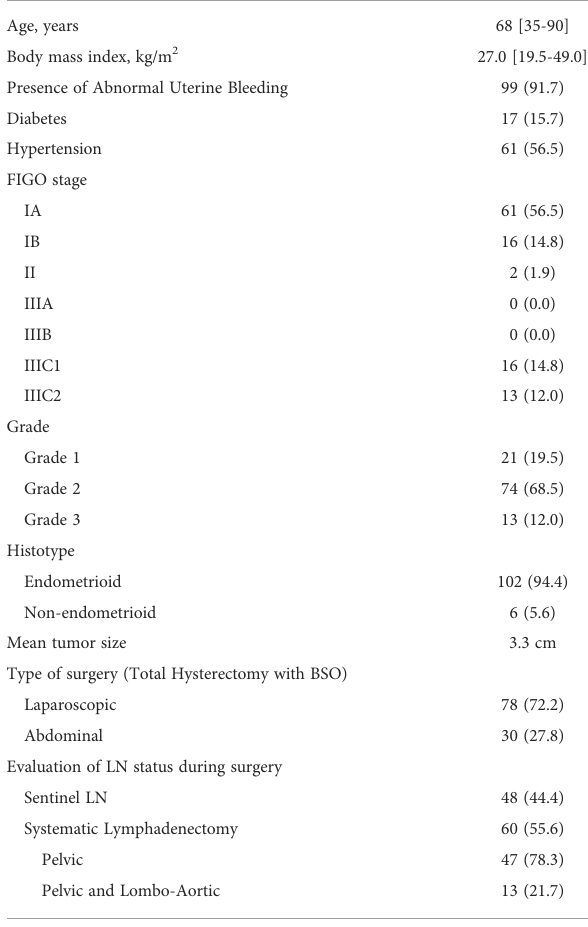
TABLE 1 Characteristics of the study population (n = 108).